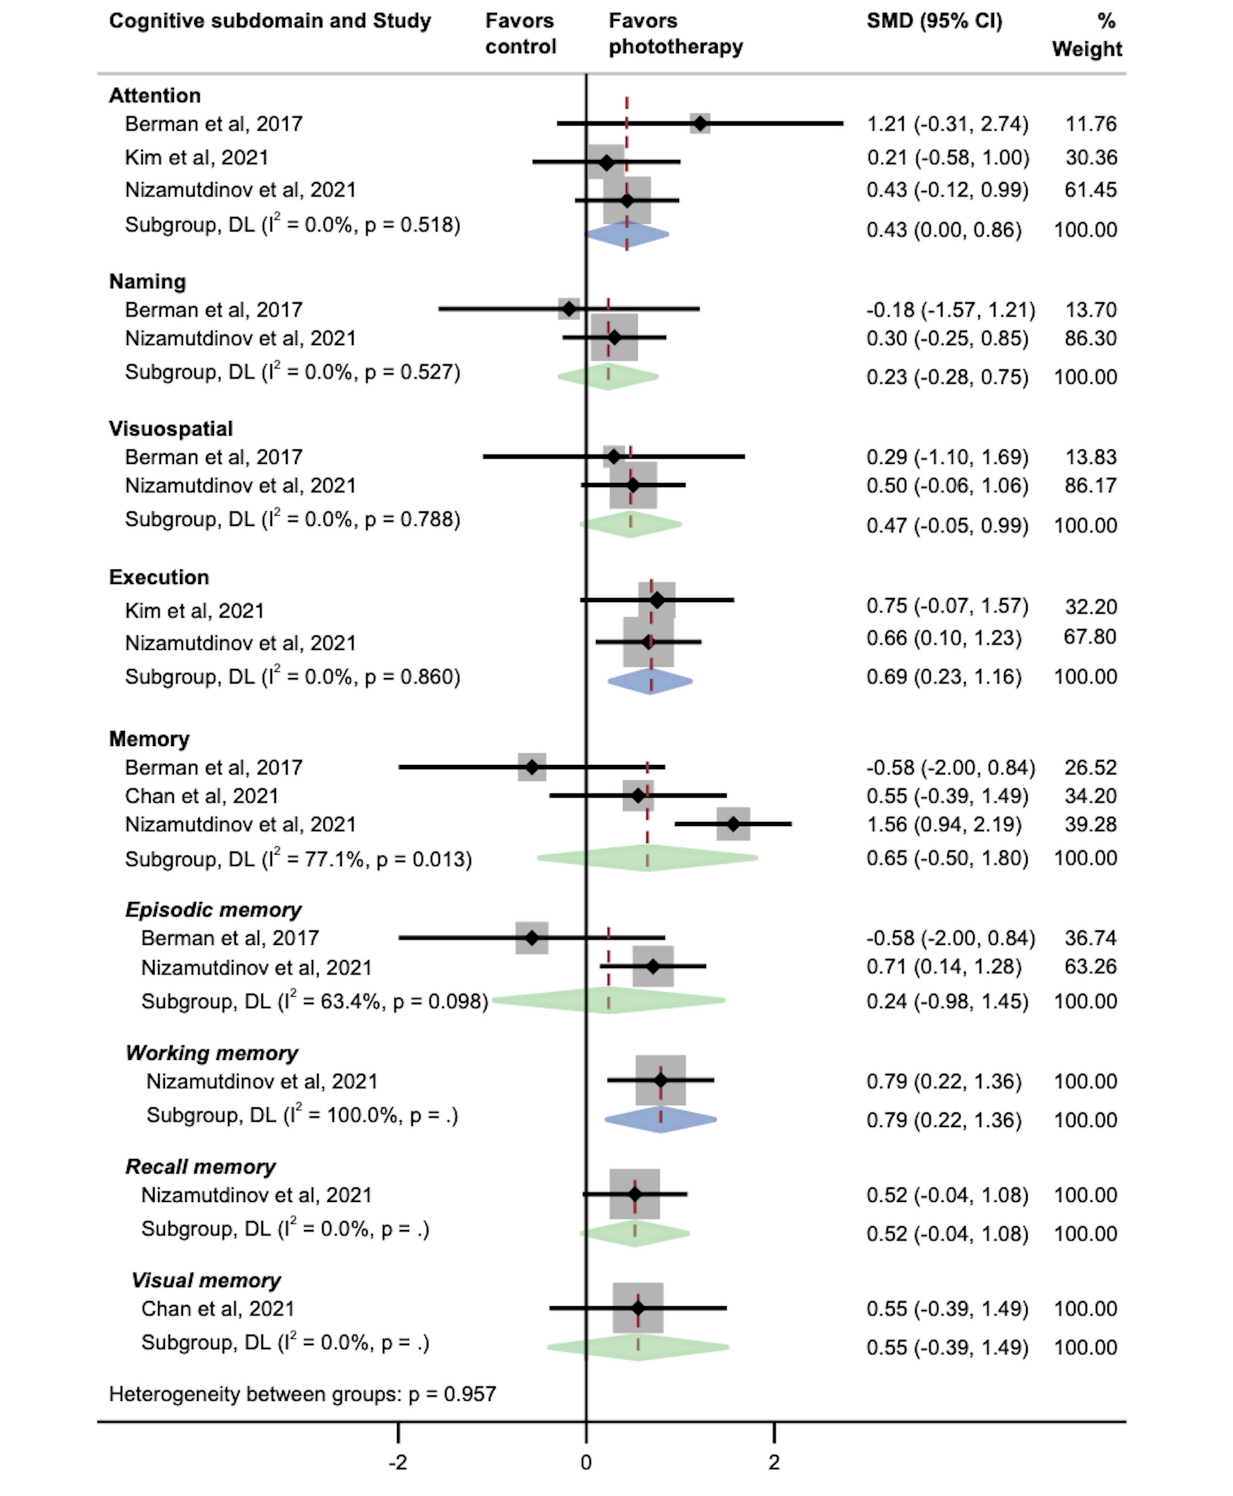
Frontiers in Aging Neuroscience |